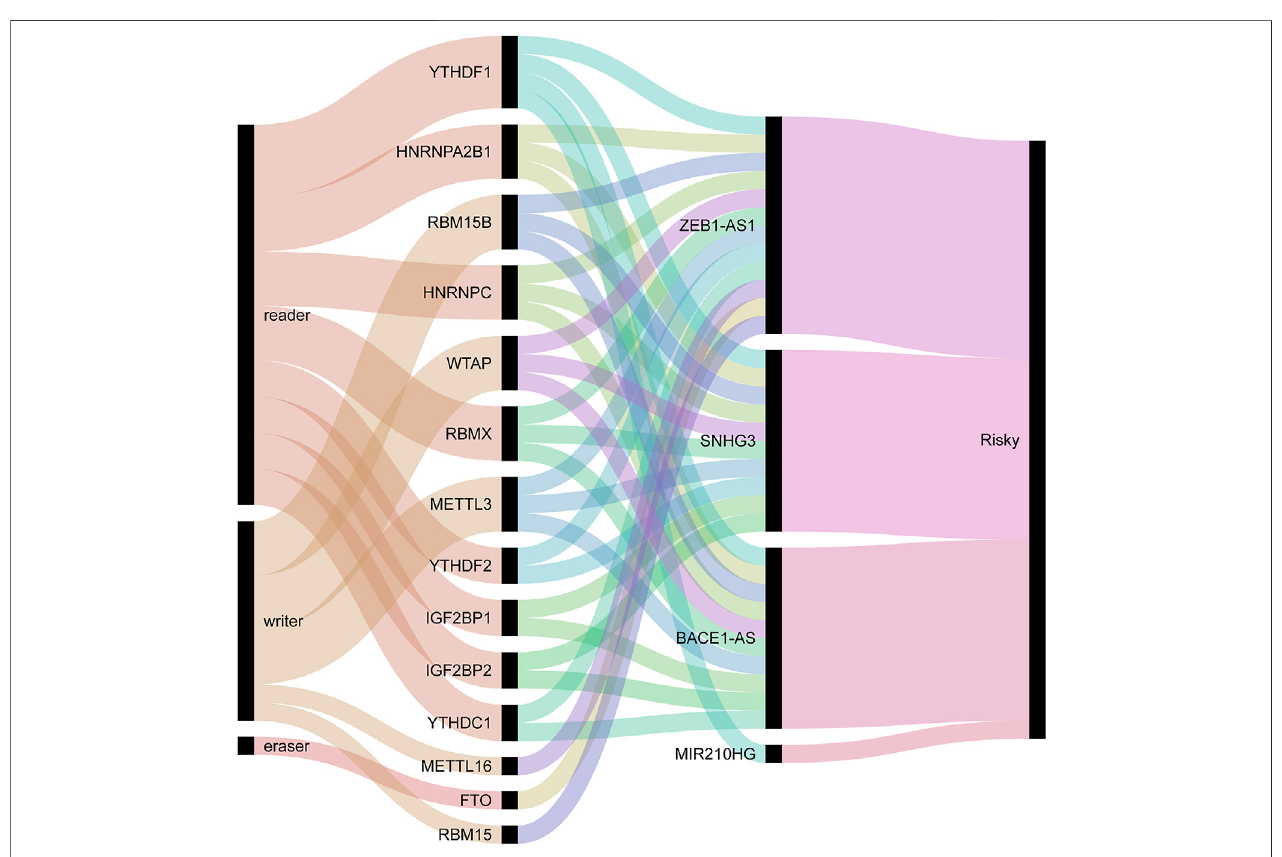
FIGURE 3 | Sankey diagram between m6A regulators and the selected four lncRNAs.